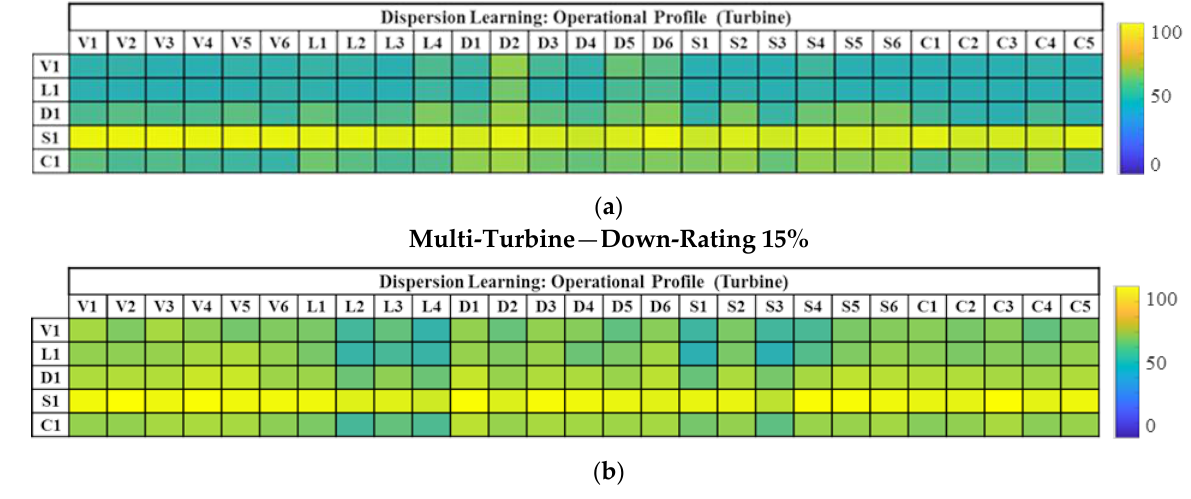
Figure 9. Performance evaluation matrix presented in Section 4.2 and Table 1 filled with PD 10 calculated using ( a ) Method 1- ‘mono’ for Down-Rating 15% (0–100 on Blue-Green-Yellow Scale) ( b ) Method 1- ‘multi’ for Down-Rating 15% (0–100 on Blue-Green-Yellow Scale).